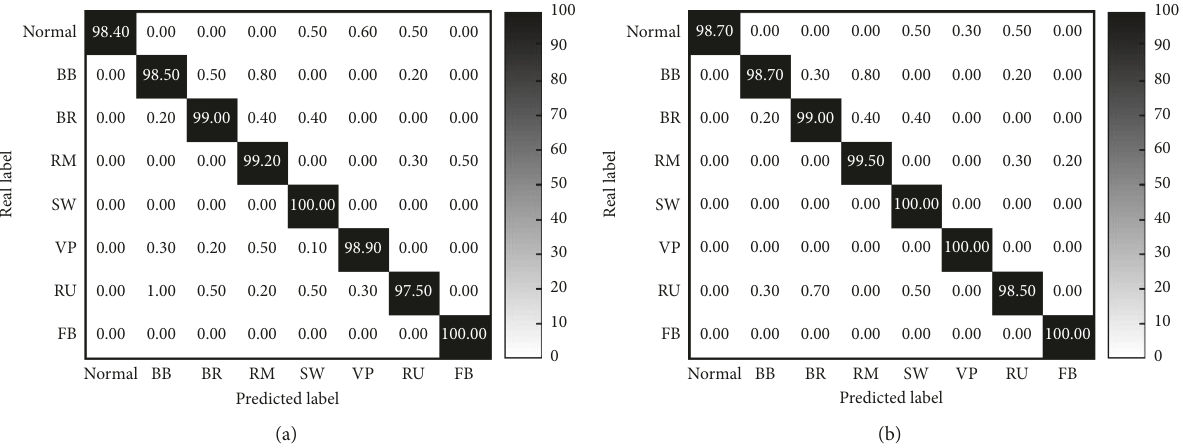
Figure 10: Confusion matrix of the classification results of two datasets. (a) Dataset 1. (b) Dataset 2.